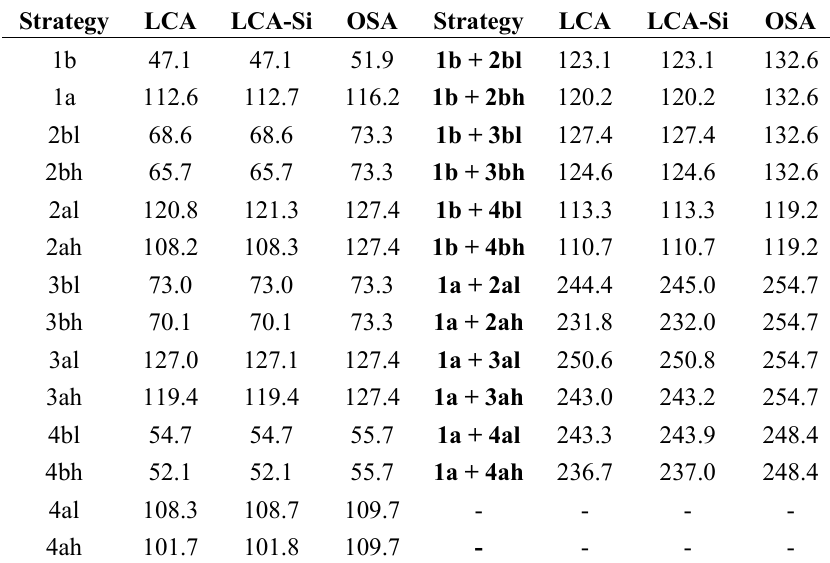
Figure 4. Reduction of Non Renewable Primary Energy use (MJ/(m 2 ·a)) from each refurbishment strategy in relation to the baseline. Positive values indicate a reduction of energy use on the operational phase. Negative values represent the energy use on the rest of the life cycle phases. Table 6. Reduction of Non Renewable Primary Energy use of each refurbishment strategy according to Life Cycle Assessment (LCA), simplified LCA (LCA-Si) and Operational Stage Assessment (OSA) (MJ/(m 2